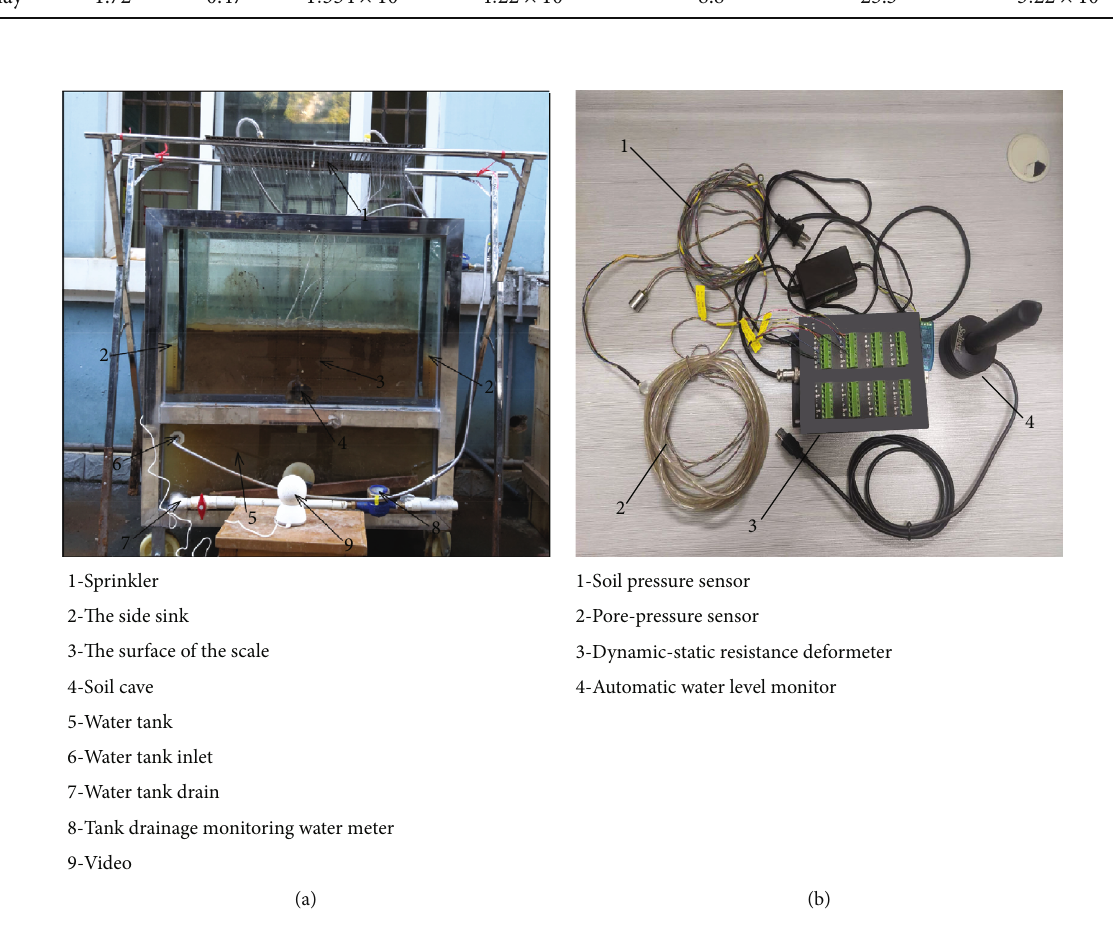
Figure 3: Physical model device and monitoring